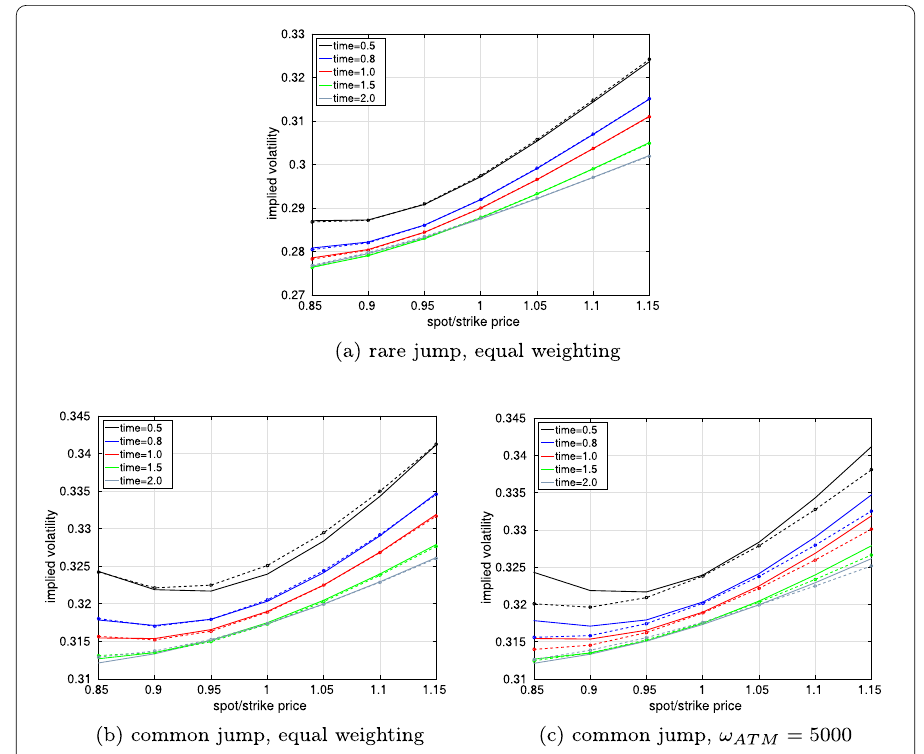
Figure 8 Implied volatilities from the ‘market’ and calibration. The solid lines represent the Bates implied volatilities, while the dashed lines are the calibrated Heston-based volatilities. The impact of weighting